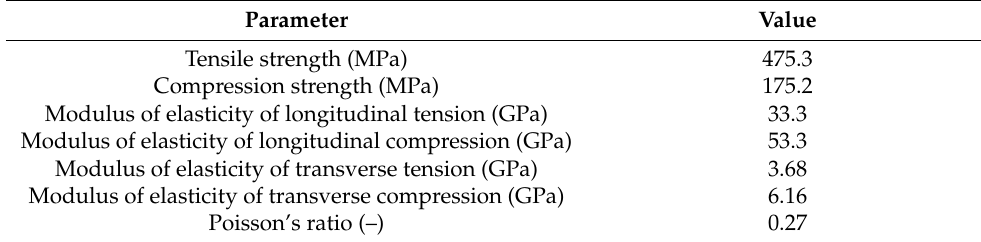
Table 1. Mechanical parameters of the GFRP material.